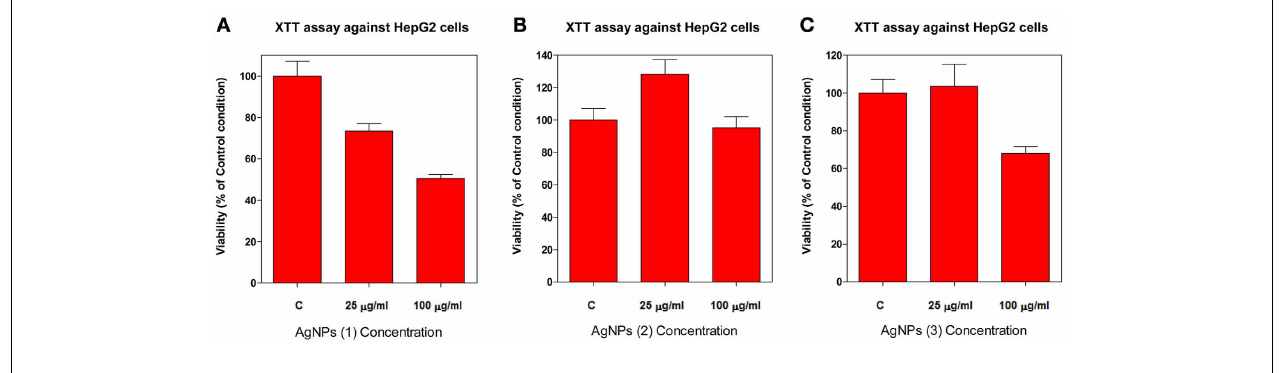
FIGURE 5 | Dose-dependent cytotoxicity of AgNPs against HepG2 cells. The cytotoxic effect of AgNPs against HepG2 cell line was evaluated by the XTT assay. Cell viability was evaluated